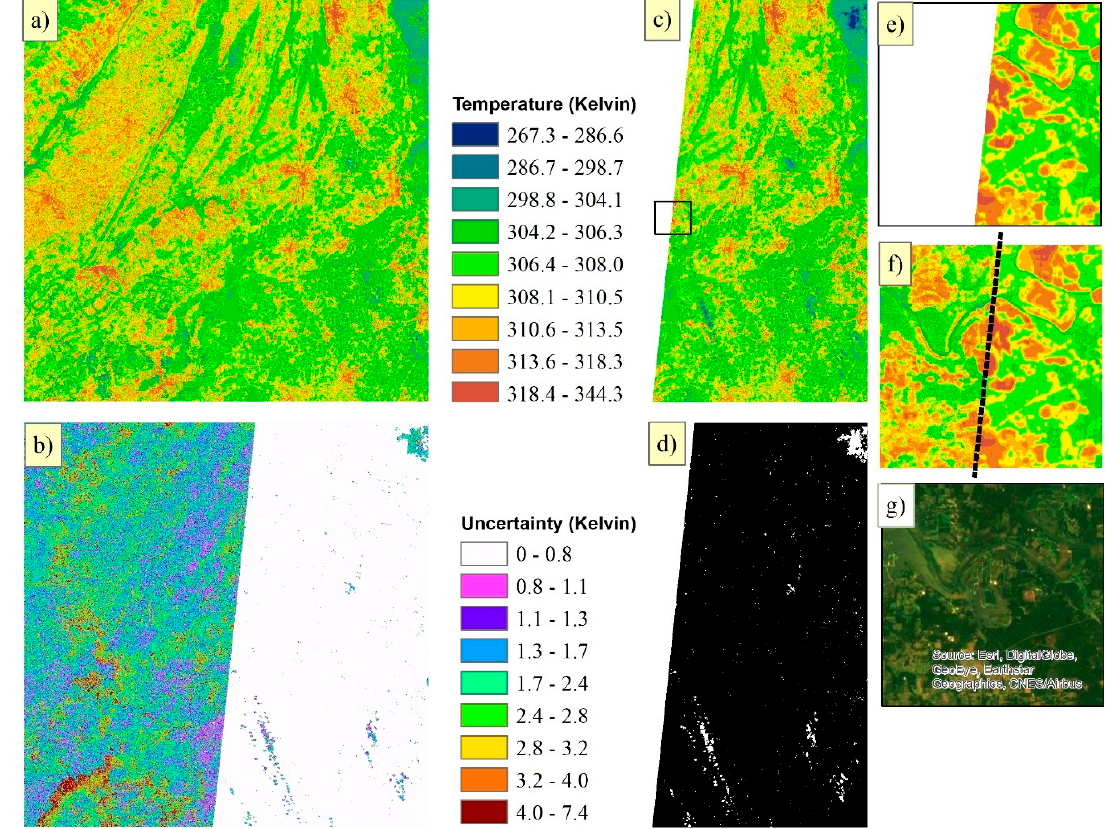
Figure 4. Land surface temperature from June 18, 2018 (Atlanta, GA) ( a ) predicted in this study and ( c ) ARD land surface temperature (LST). Panel ( b ) shows the model uncertainty of predictions. Panel ( d ) shows the distribution of valid data (black) and cloud (white) based on the Landsat pixel QA band. (Panel ( e ) and ( f ) are zoom-in views of ( a ) and ( c ), and the black dashed line shows the boundary between the observed and predicted data. Panel ( g ) is a high-resolution image of the same region from Esri, DigitalGlobe.